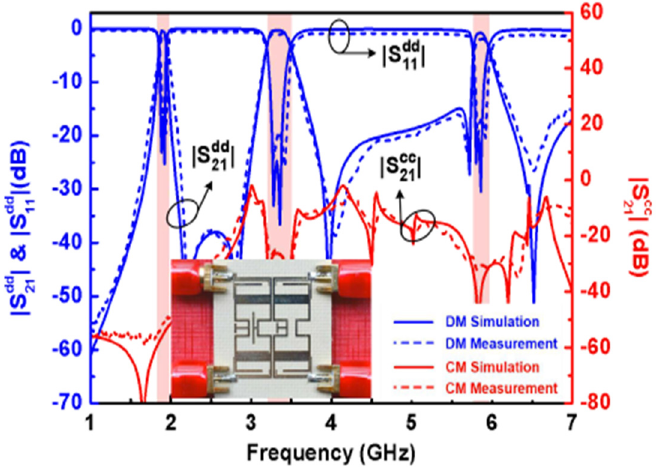
Figure 13. Simulated and measured frequency responses of the balanced tri-band BPF [66].